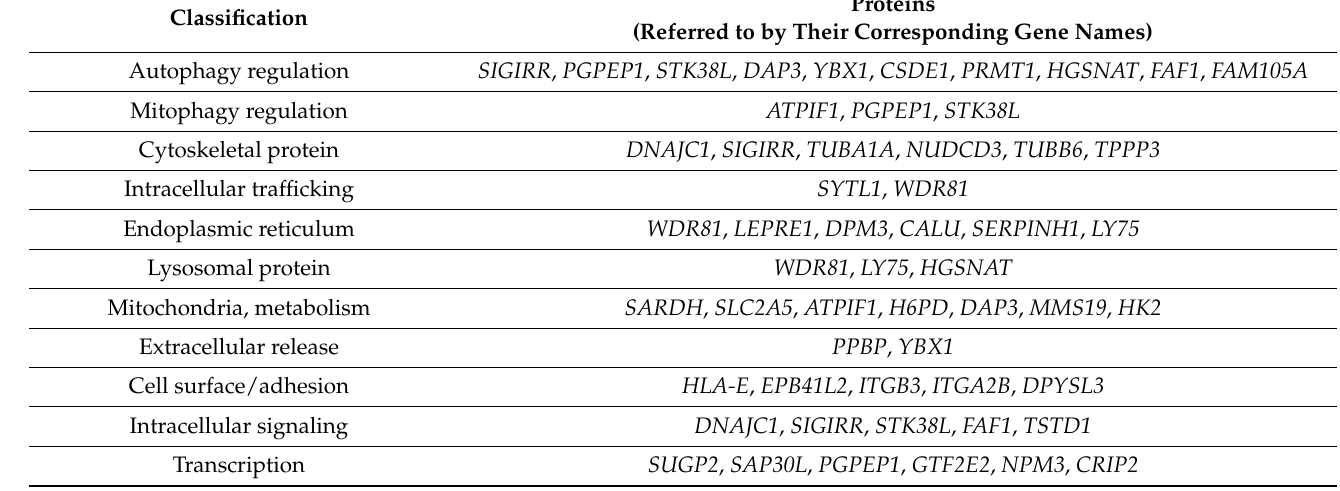
Table 1. A classification of proteins that show significantly different levels when comparing AML cells with strong and weak antiproliferative effects of chloroquine. The gene names are shown to the right. The proteins are described in detail in Table S3 and the results of the proteomic analyses are summarized in Table